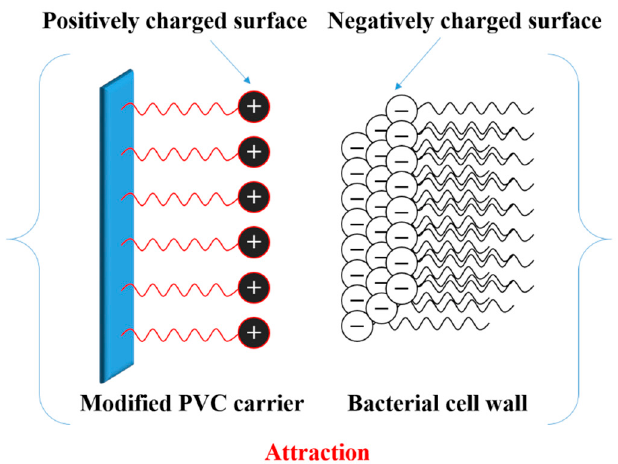
Figure 12. The electrostatic interactions between unmodified PVC / modified PVC and bacteria.